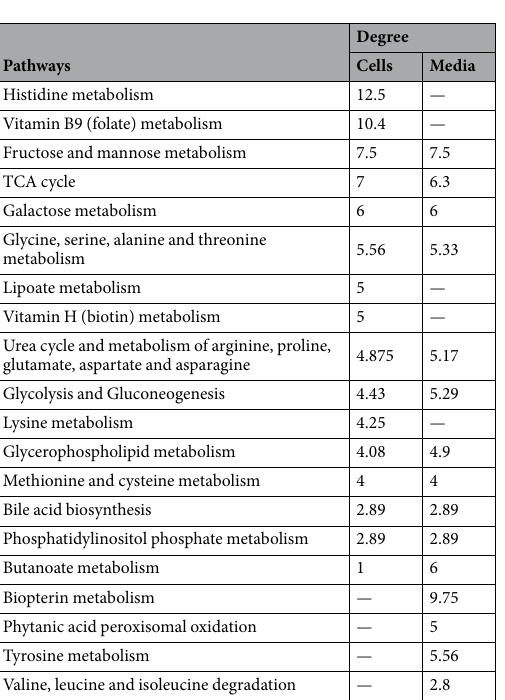
Table 2. List of HSP65 mediated metabolic pathways (both intracellular and extracellular) with average degree